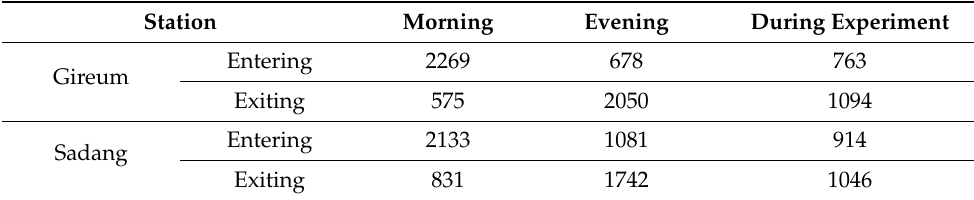
Figure A2. Fitted Taniguchi model [56] for subject 1, case 3. Table A1. Average number of passengers entering and exiting the Gireum and Sadang station platforms of Seoul Metro in the morning, evening and during experiment [61].